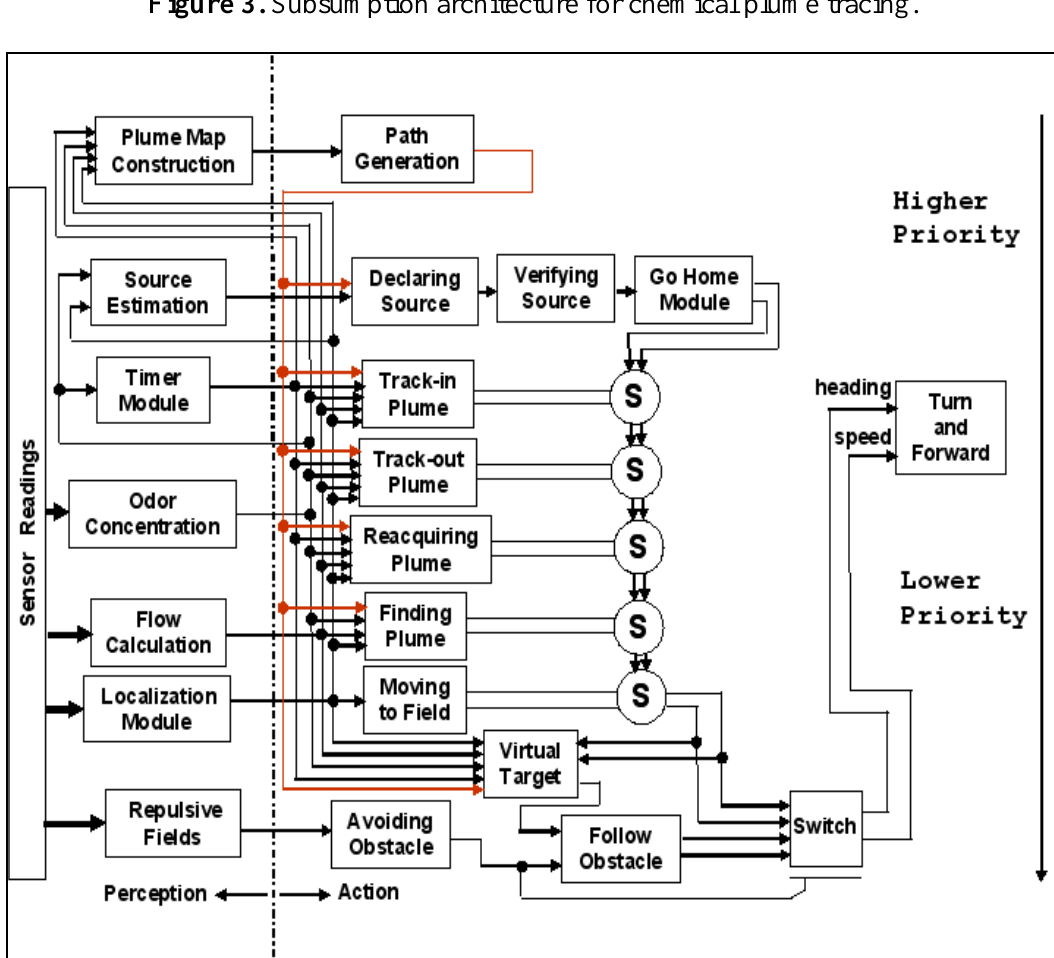
Figure 3. Subsumption architecture for chemical plume